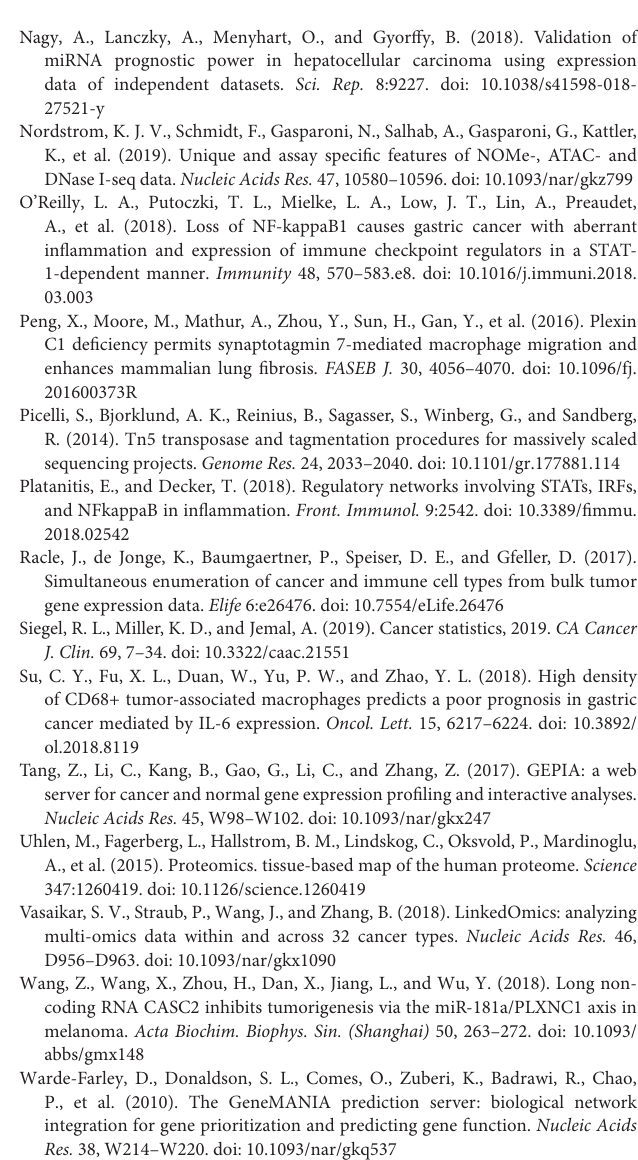
Supplementary Figure 1 | The expression pattern of PLXNC1 in other solid tumors. Supplementary Figure 2 | The relative expression of PLXNC1 mRNA in six patients. Supplementary Table 1 | The result of 1,639 transcription factors genes.